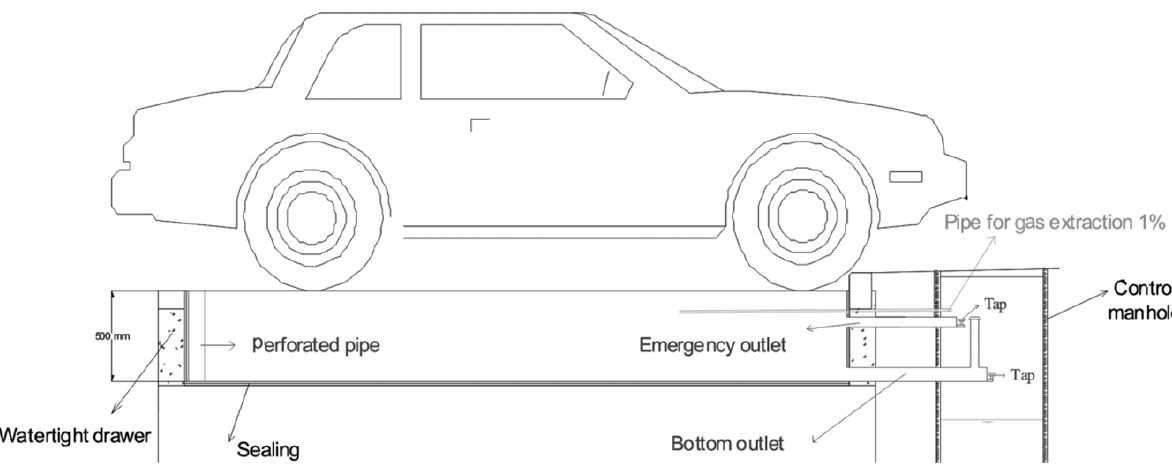
Figure 12. Cross section of Las Llamas experimental parking bay